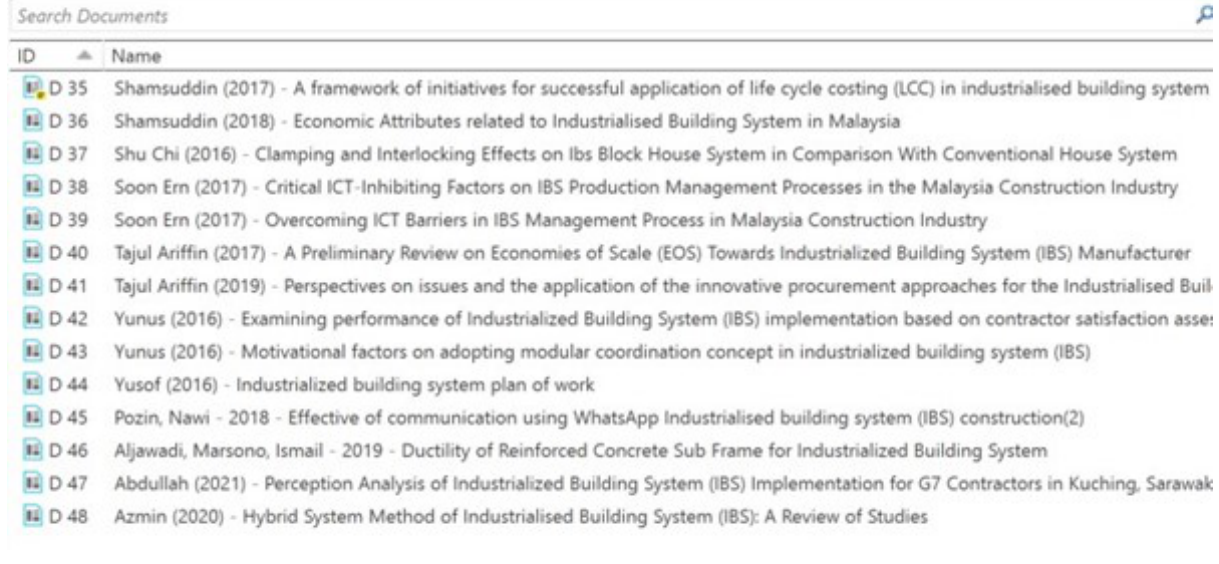
Fig. 2. Documents extracted from Mendeley metadata